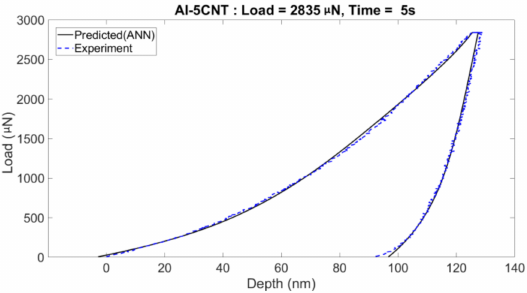
Figure A1. Comparison: experiment vs. predicted for maximum load of 2835 µ N, loading rate of 283 µ N/s, and holding time of 5 s for carbon nanotube reinforced aluminum composite (Al-5CNT)